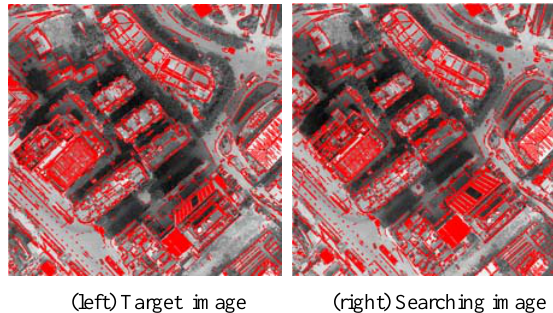
Figure 6. The line extraction results by improved Hough Transform